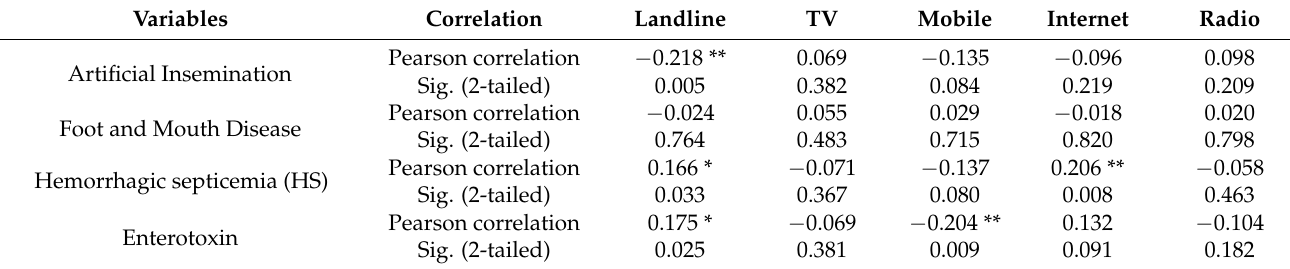
Table 2. Pearson correlation of awareness about artificial insemination and other diseases with the utilization of EM. Variables